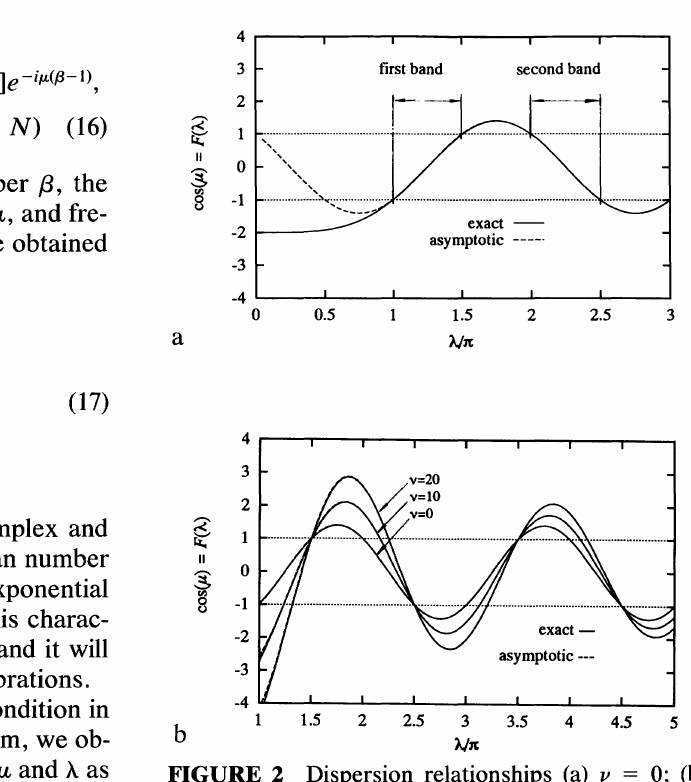
FIGURE 2 Dispersion relationships (a) v = 0; (b) v = 0,